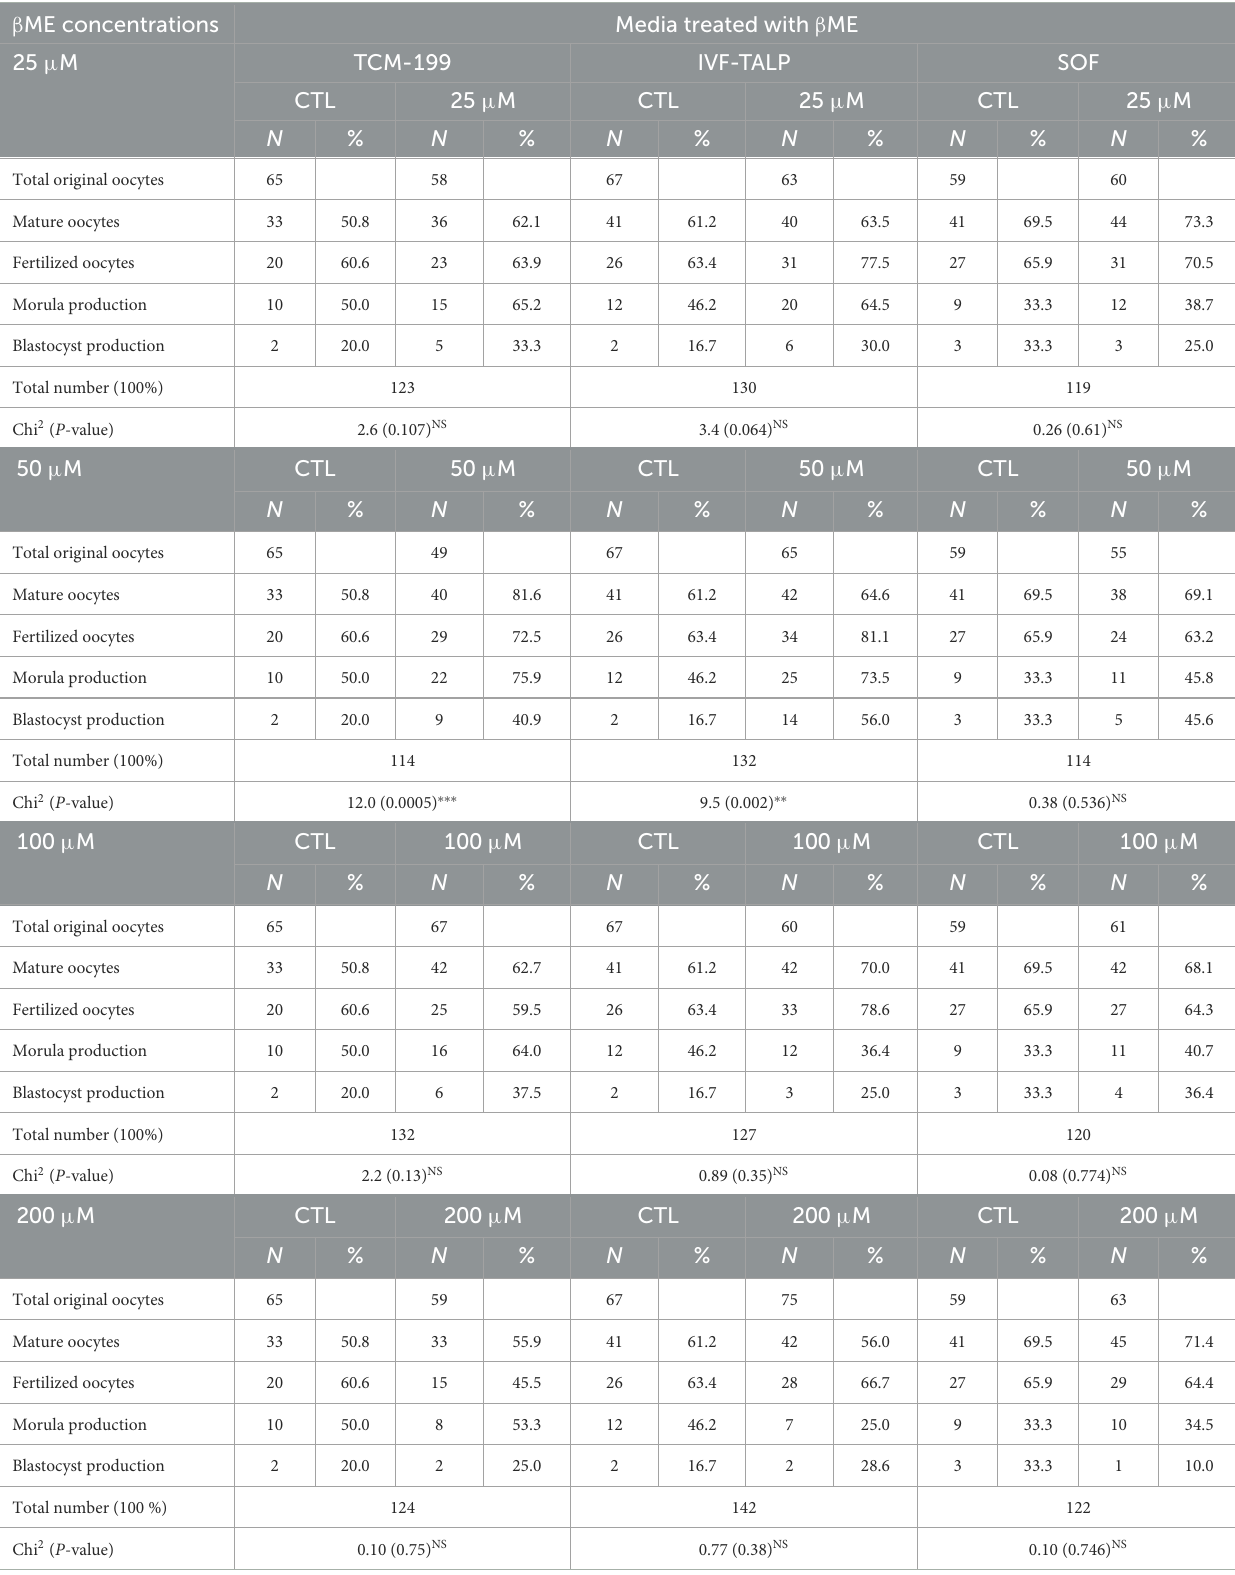
TABLE 2 Effects of Beta-Mercaptoethanol ( β ME) added to TCM-199, IVF-TALP, and SOF media on the embryo stages in buffaloes; oocyte maturation, fertilization, cleavage/morula, and blastocyst development. β ME